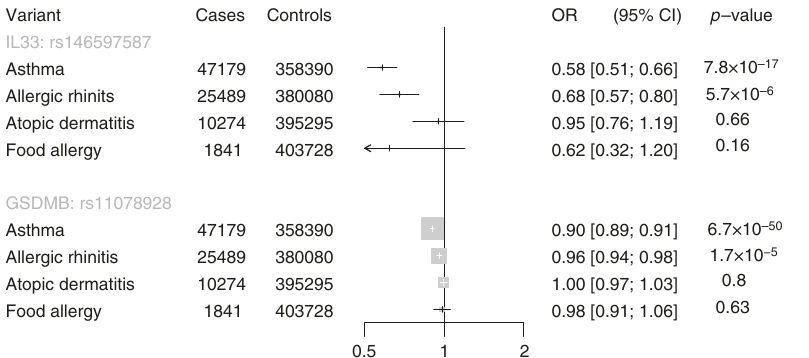
Fig. 3 Association of predicted loss-of-function variant in GSDMB and IL33 with allergic disease in UK Biobank. Estimates were derived in UK Biobank using logistic regression, adjusted for age, sex, ten principal components of ancestry, and array